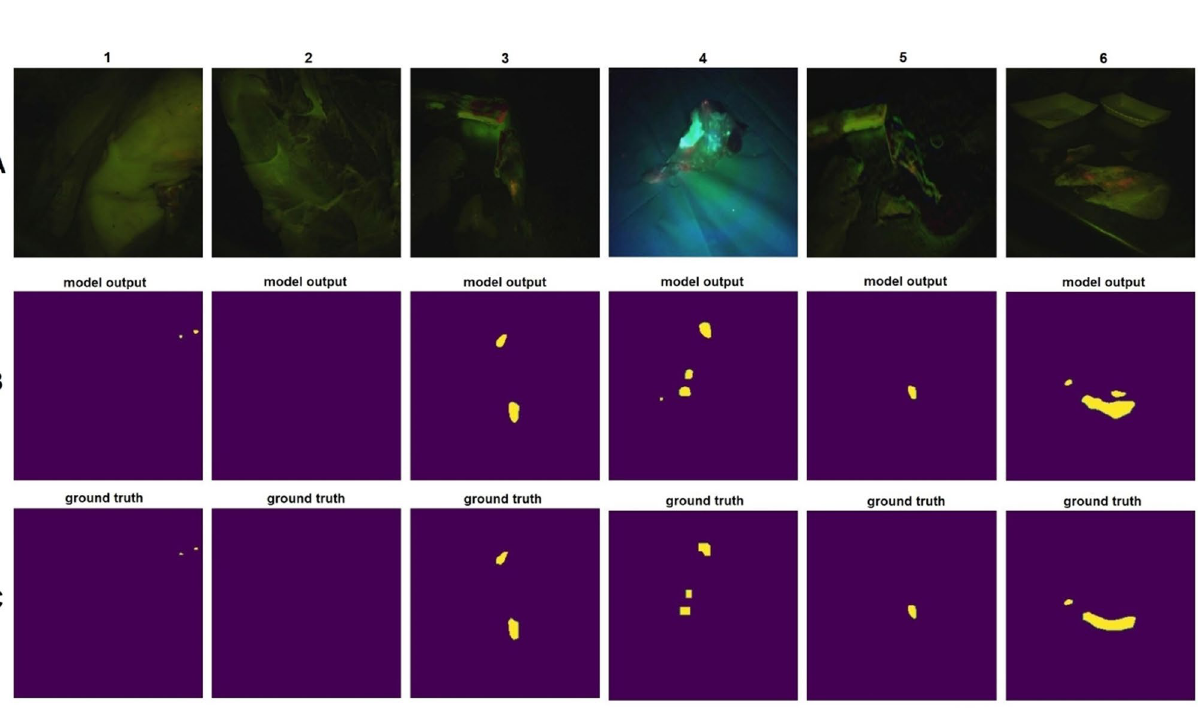
Figure 8. Performance of the semantic segmentation method on some randomly selected test frames. ( A ) The input frames to the semantic segmentation model. ( B ) Segmented image output by the model. ( C ) The ground truth segmented image by human